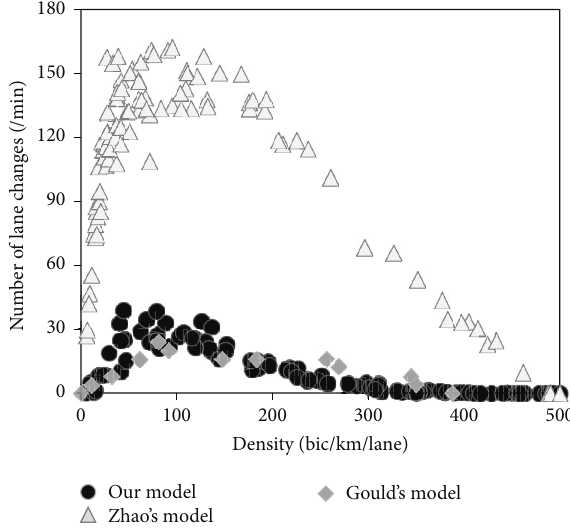
Figure 5: Simulation of fundamental diagram.